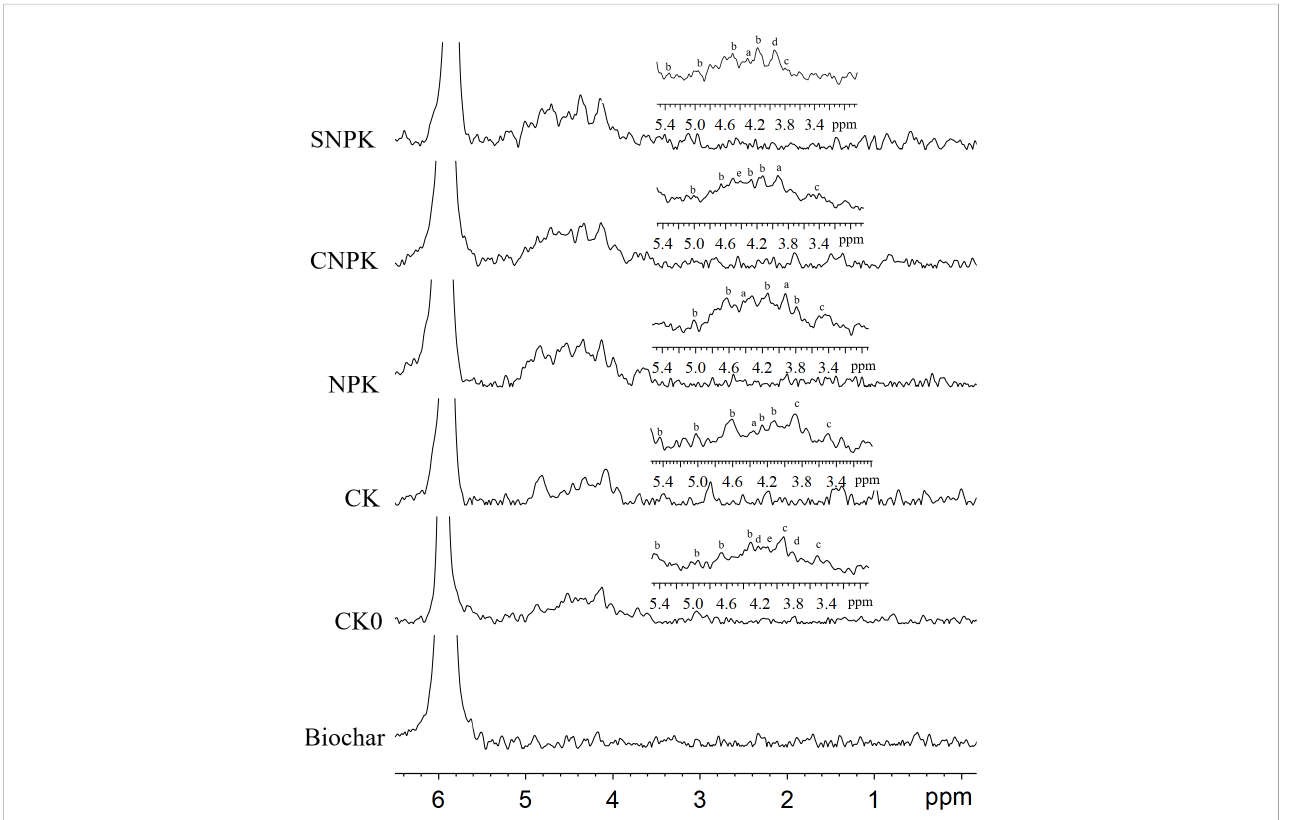
FIGURE 5 The solution 31-phosphorus nuclear magnetic resonance spectra of the biochar-treated sample and the orthophosphate and monoester under different treatments in detail (5.4 to 3.0 ppm). a: adenosine monophosphate; b: myo-Inositol hexakisphosphate; c: scyllo-Inositol hexakisphosphate; d: neo- Inositol hexakisphosphate; and e: D-chiro-Inositol hexakisphosphate. CK0: initial soil; CK: non-fertilizer; NPK: NPK fertilizer; CNPK: biochar + NPK fertilizer; SNPK: corn stover + NPK